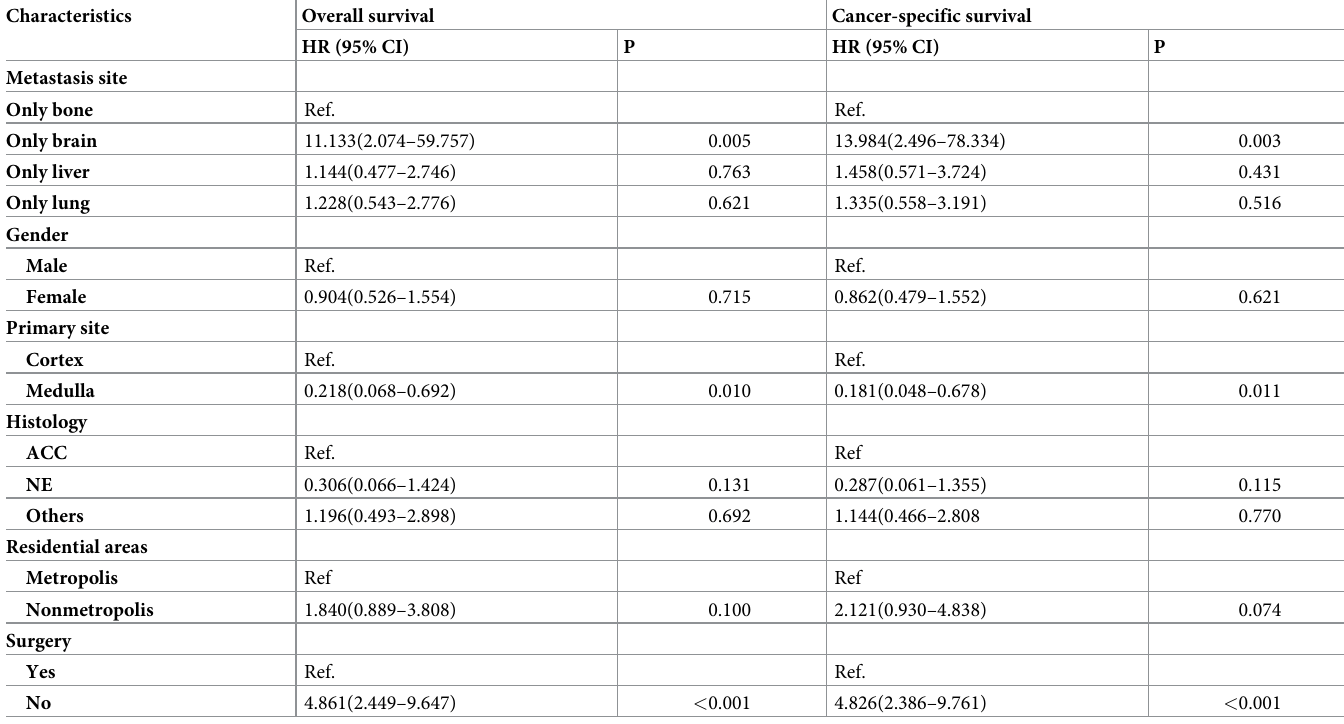
Table 5. Multivariate survival analysis predicting overall survival and cancer-specific survival in patients with four single metastases.